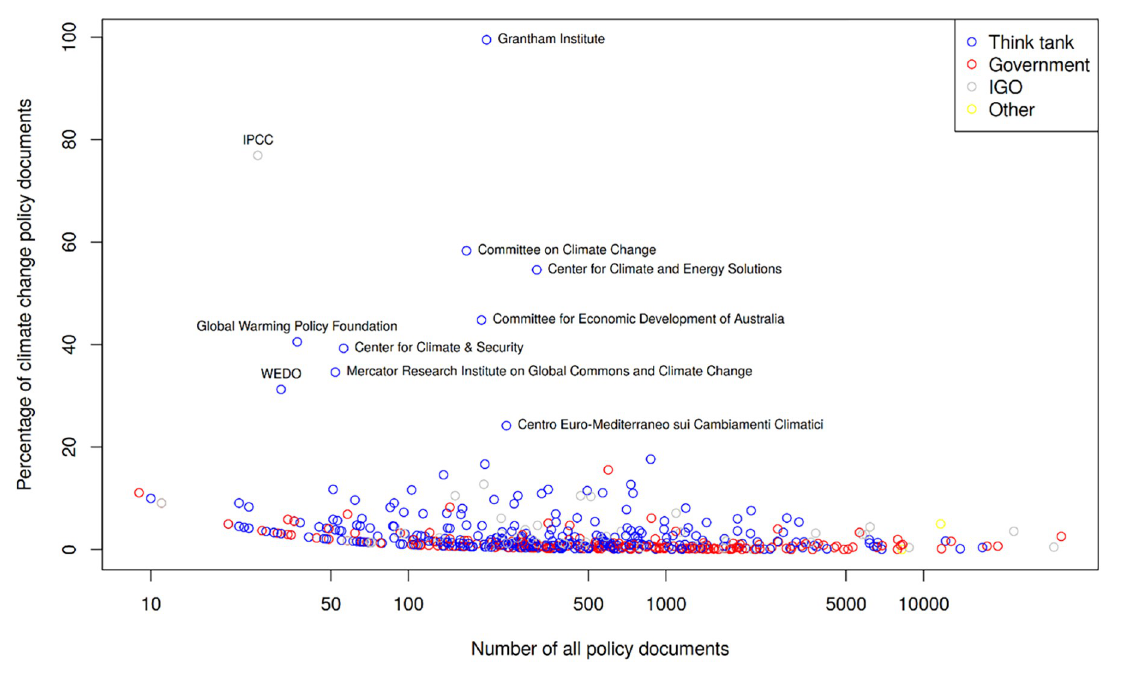
Fig 3. Number of policy documents and percentage of climate change policy documents on the institutional basis (Spearman rank correlation = 0.55; an interactive version can be viewed at: https://s.gwdg.de/2dC41E).